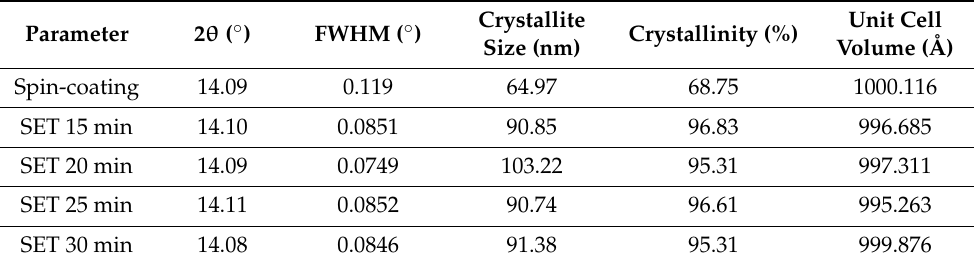
Figure 3. XRD of various perovskite structures fabricated via different techniques: ( a ) Pattern of MAPbI 3 in the 2 θ range of 10–30 ◦ ; ( b ) Pattern of MAPbI x Cl 3 − x in the 2 θ range of 10–30 ◦ ; ( c ) Pattern of MAPbI x Cl 3 − x for both the techniques in the 2 θ range of 12–14.5 ◦ . Table 2. Structural information of perovskite thin films for MAI (Spin-coating, SET)-PbI 2 -MAI (SET) structure with different parameters for first